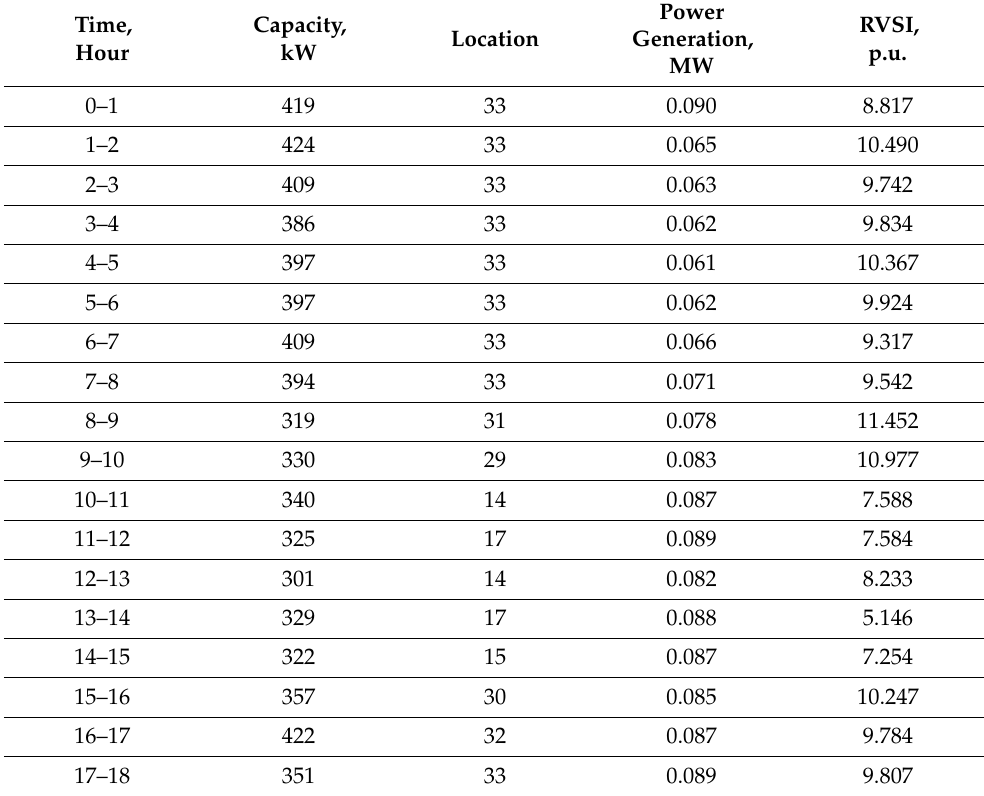
Table 5. Final capacity and location of BESS per hour (one BESS